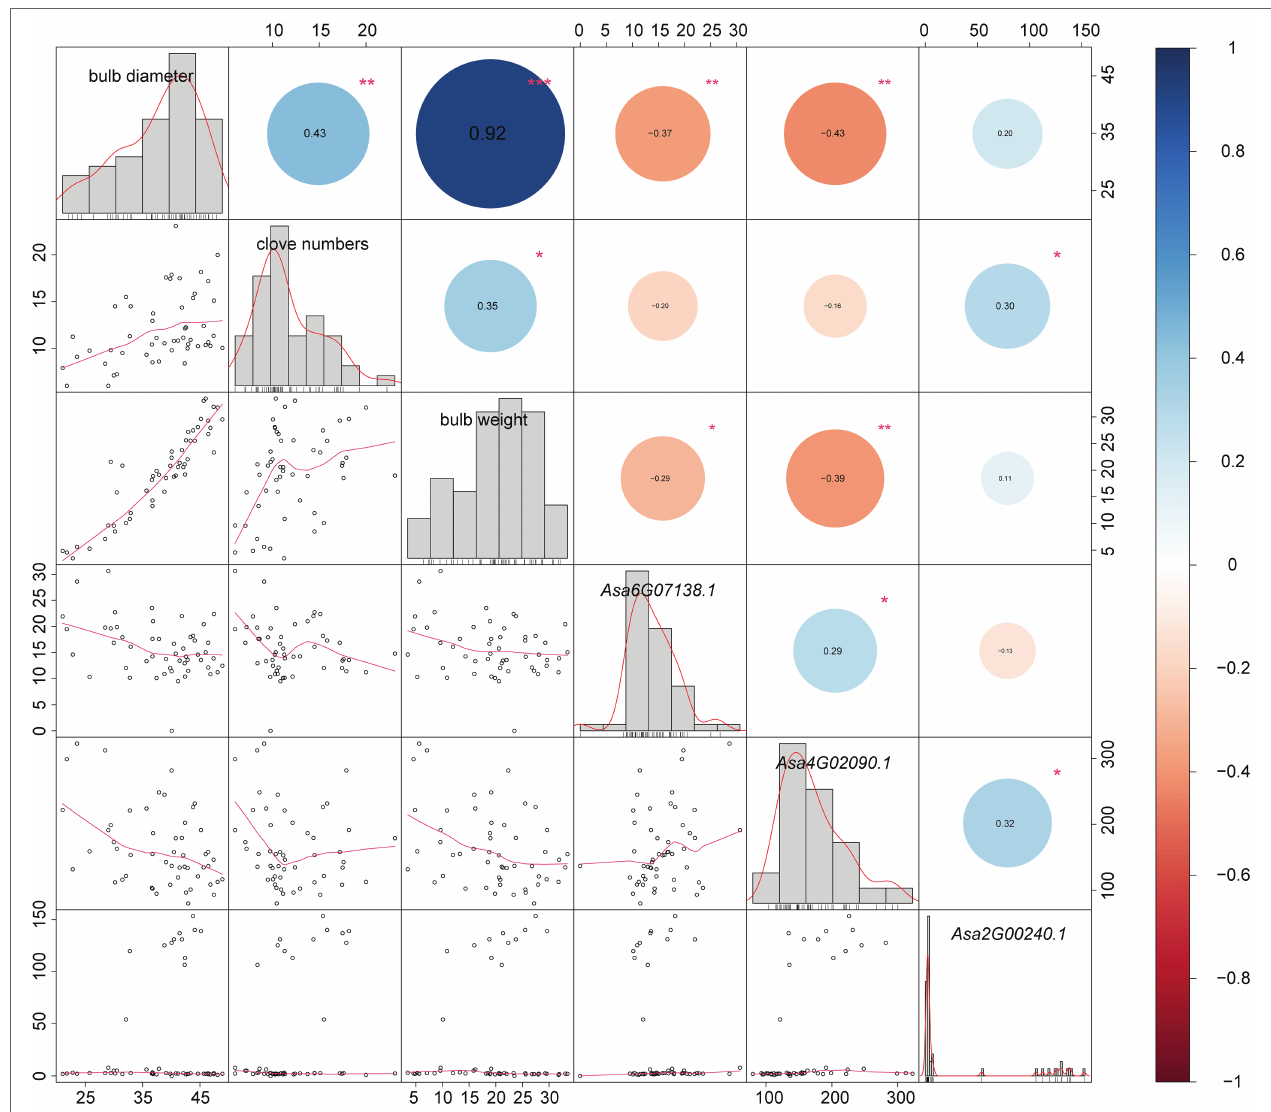
FIGURE 7 | Correlation diagrams between garlic bulb traits (bulb diameter, bulb weight, and clove numbers) and DELLA genes. The correlation diagrams are represented by bar graphs, red curves, and scatter plots simultaneously. Numbers in colored dots are correlation coefficients, dot size indicates correlation degree, red indicates negative correlation, and blue indicates positive correlation. *, **, and *** indicate significant correlations at the 0.05, 0.01, and 0.001 levels, respectively. As the CDS sequences are identical, a pair of tandem repeat genes are represented by one gene